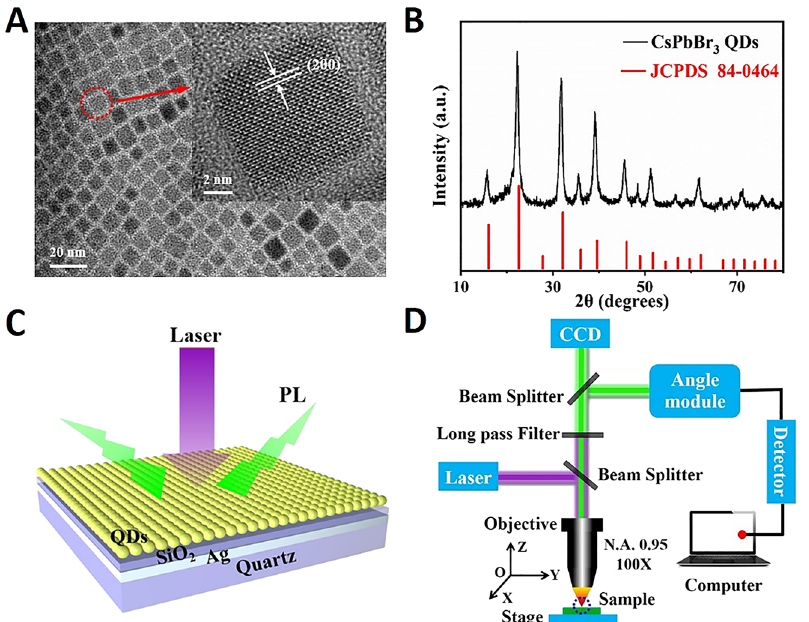
Figure 1: Structural characterizations of CsPbBr 3 perovskite QDs and experimental setup for PL